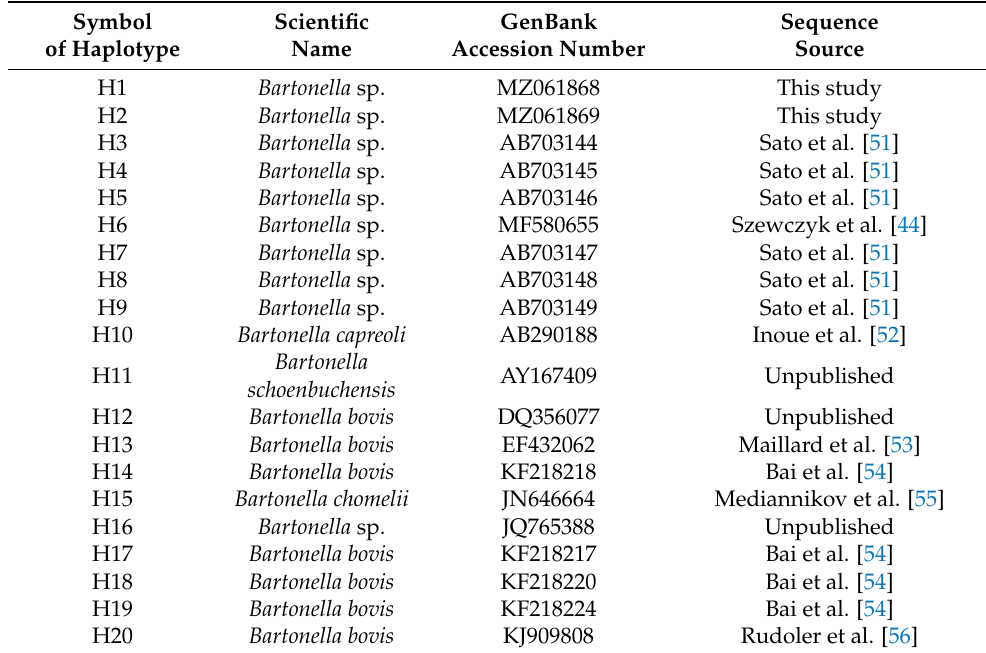
Table 1. List of species and GenBank accession numbers of their RNA polymerase beta subunit ( rpo B) gene sequences used in the network phylogenetic analysis (Figure